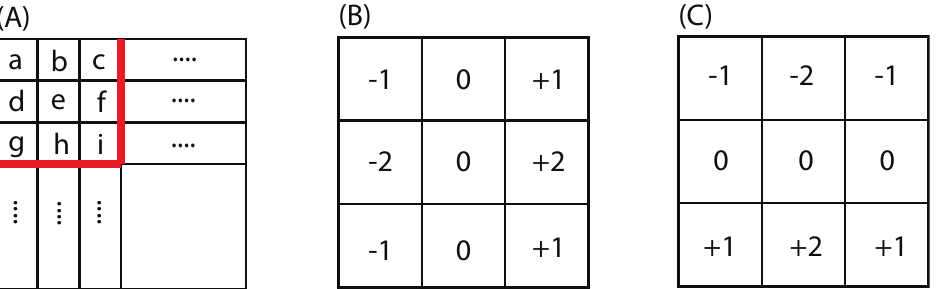
Figure 1. Gradient measurement in the Sobel edge detector: ( A ) the original image with the evaluated brightness in each pixel; ( B , C ) are the convolution masks in the x -direction and the y -direction,